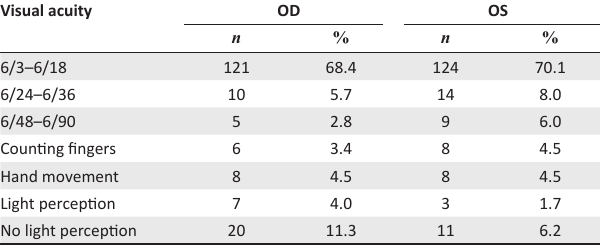
posterior segment ocular manifestations was significantly different at 453.8 cells/μL ± 402.8 cells/μL and 187.50 cells/μL ± 101.6 cells/μL ( p < 0.05). The average duration of HIV infection was 6.75 ± 2.3 years.